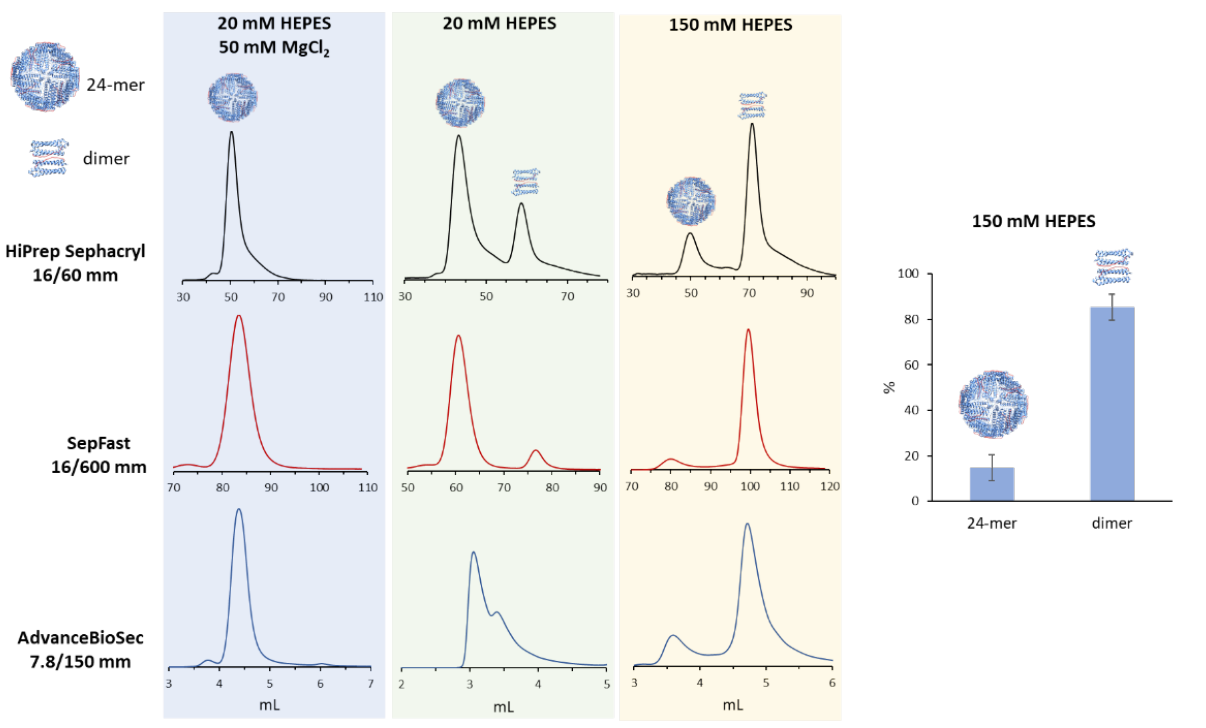
Figure 6. Size-exclusion chromatography of HumFtR150A/K151A. SEC analysis performed with three different stationary phases (HiPrep Sephacryl, SepFast and AdvanceBioSec) using different mobile phase compositions (20 mM HEPES containing 50 mM MgCl 2 ; 20 mM HEPES; 150 mM HEPES). At 150 mM HEPES, HumFtR150A/K151A is mainly present as a dimer (histogram on the right, data are presented as mean ± SD, n = 3).